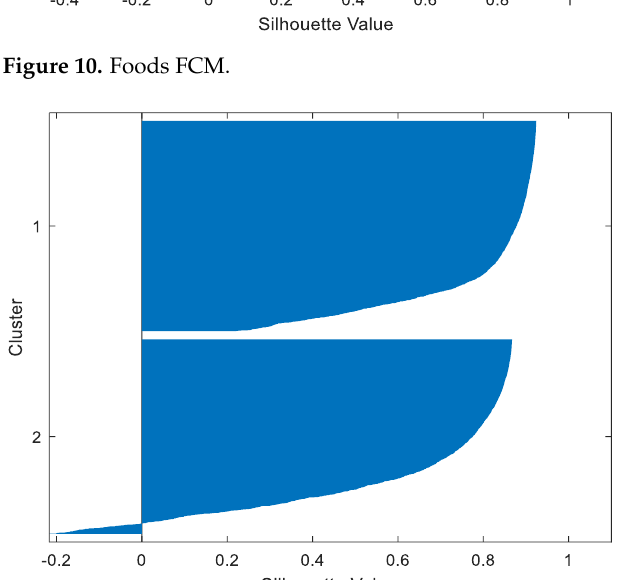
Figure 11. Foods GMM.